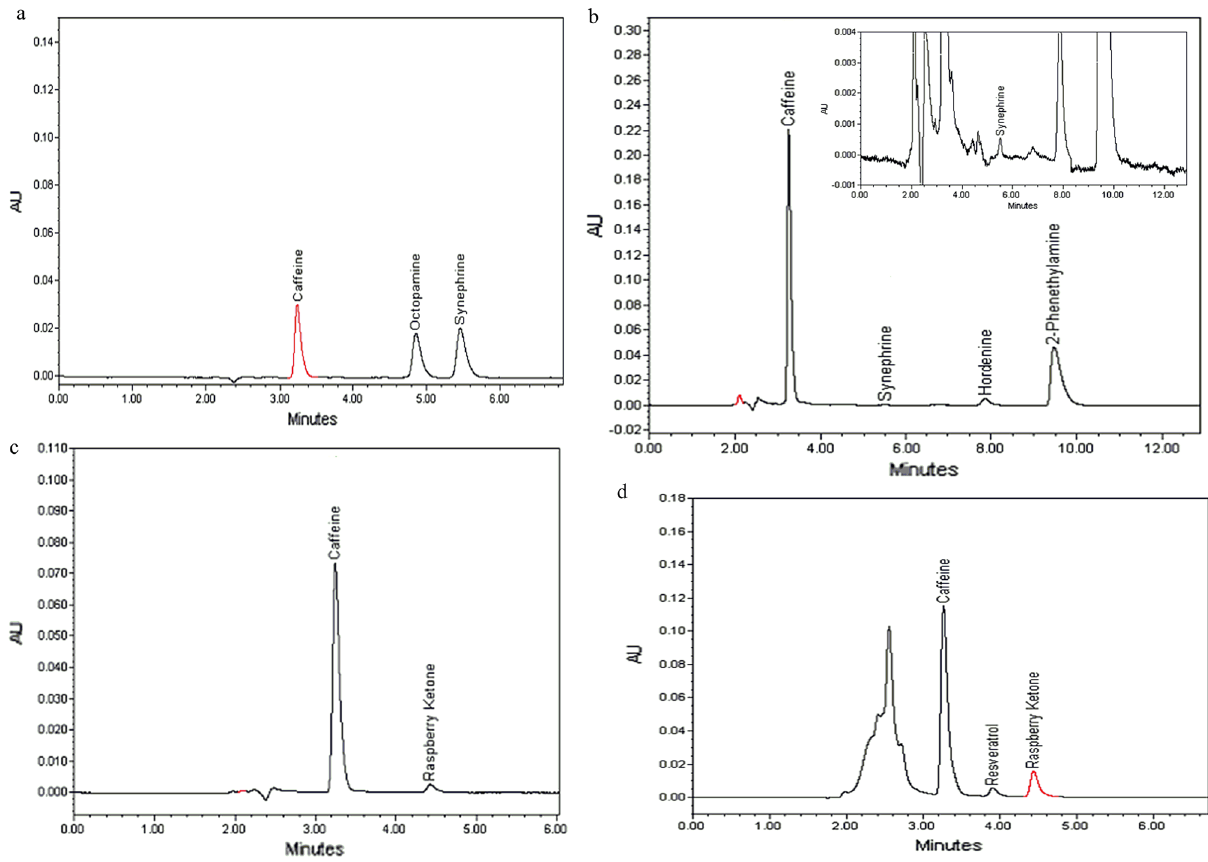
Figure 2. HPLC–PDA chromatogram of Dietary supplement samples ( a sample 1, b sample 2, c sample 3, and d sample 4).